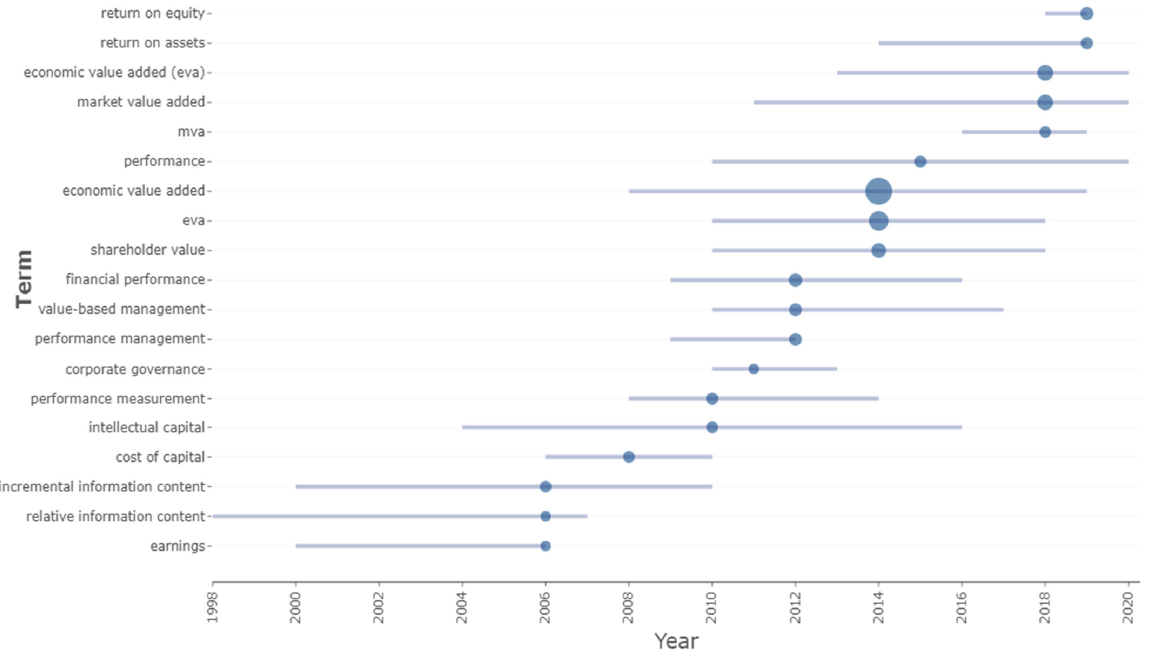
Figure 10. Trending topics in EVA research.